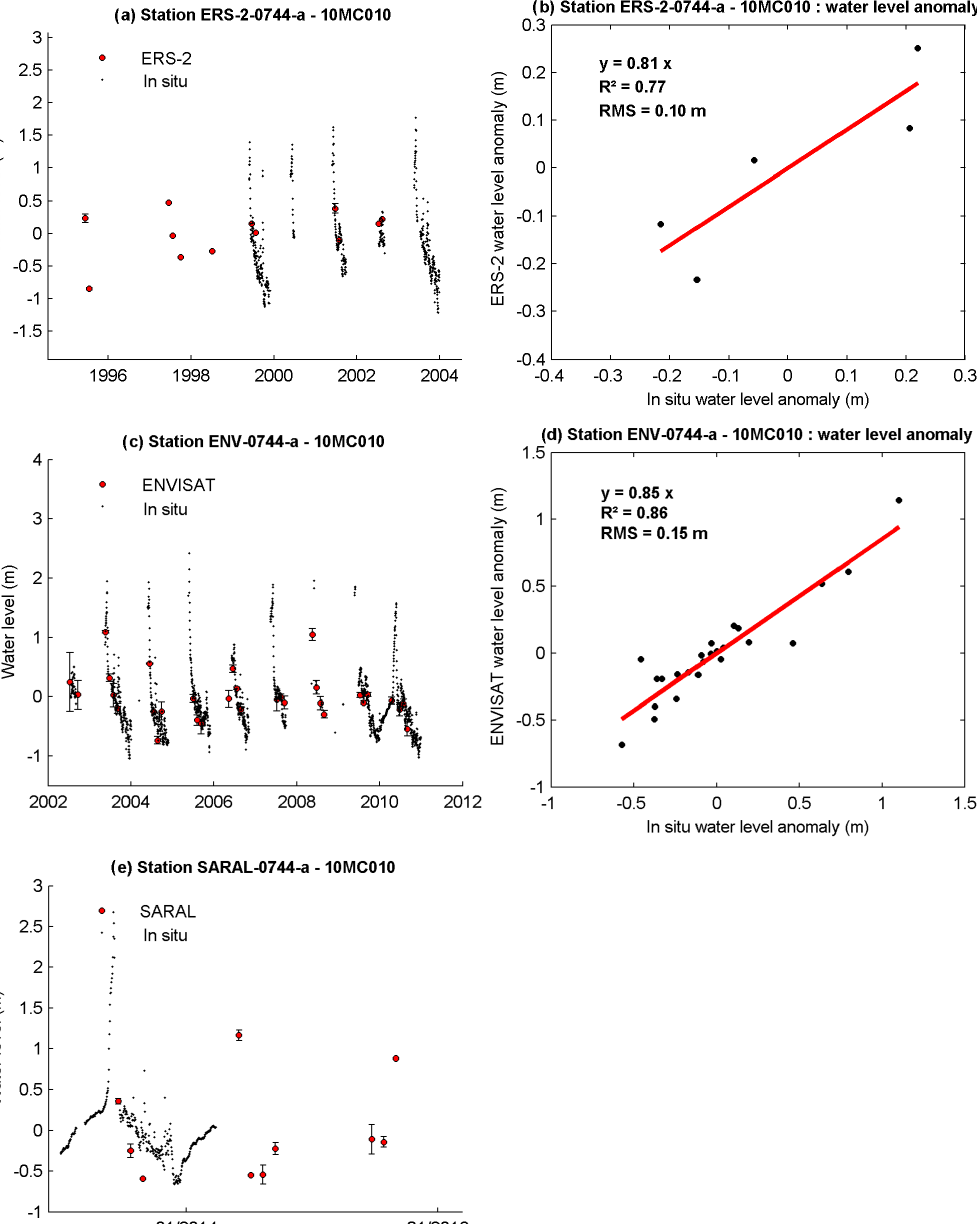
Figure 6. Altimetry-based water levels from 1995 to 2015 compared with in situ water levels for the station 0744-a, located in the downstream part in the Mackenzie Delta, using (a) the ERS-2 mission and (b) a water level anomaly with statistic parameters, (c) the ENVISAT mission and (d) a water level anomaly with statistic parameters, and (e) using SARAL